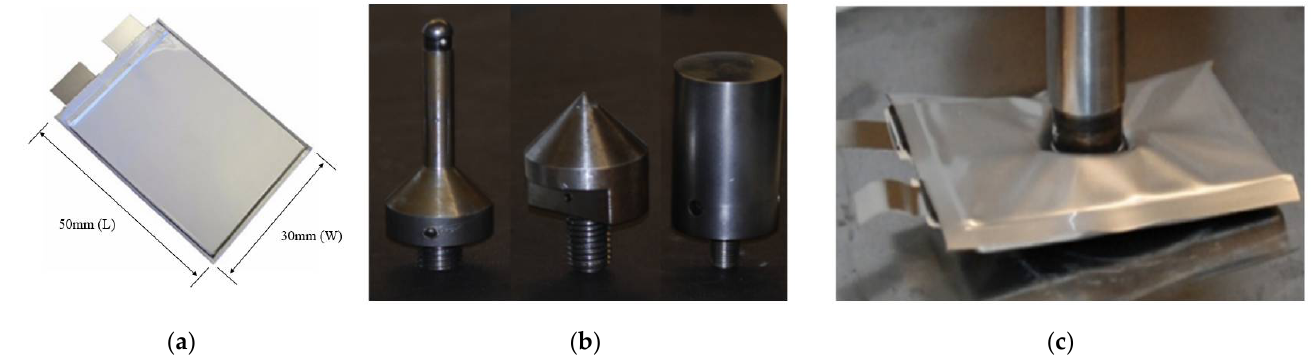
Figure 1. The pouch type LIB cell indentation test: ( a ) pouch type LIB cell; ( b ) hemispherical, conical, cylindrical indenter; ( c ) an example of indented LIB cell [12,19]. Reproduced from [12,19], Sahraei et al.: 2012, 2014.